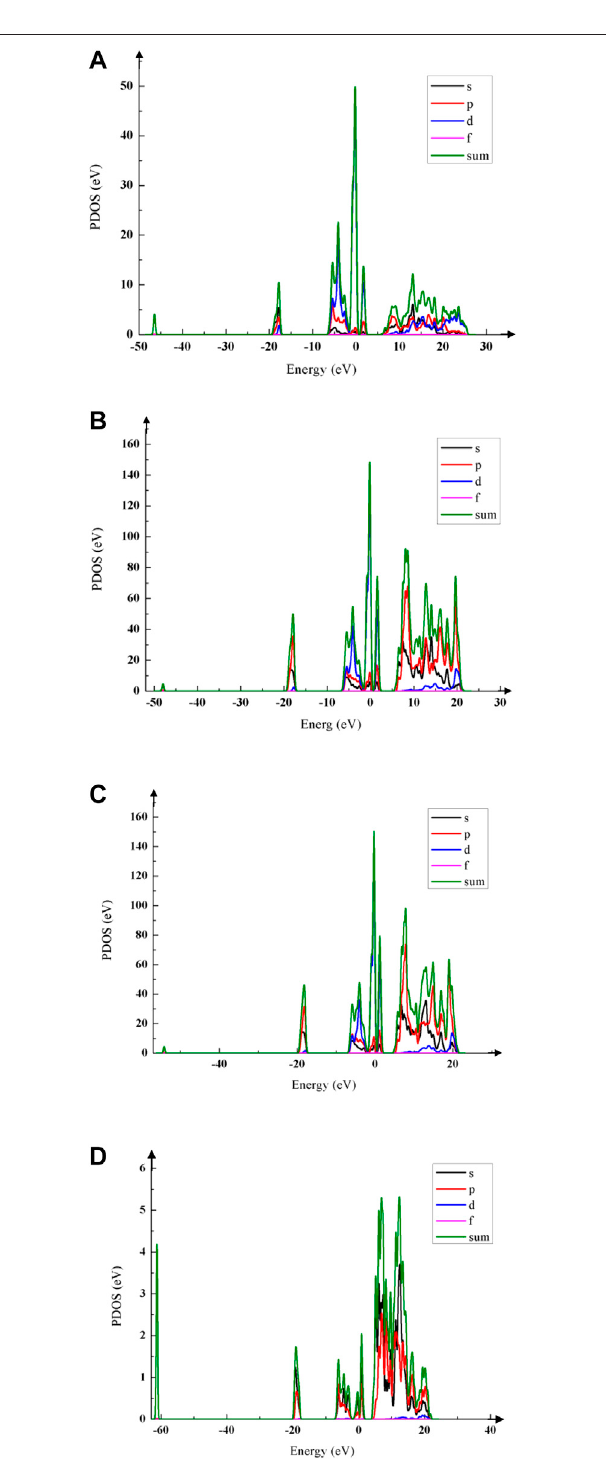
FIGURE 3 | PDOS schemas of Li 1 − x Na x Ni 1/3 Co 1/3 Mn 1/3 O 2 with different Na-doping amount x . (A) When x (cid:2) 0 mol, LiNi 1/3 Co 1/3 Mn 1/3 O 2 is not doped. (B) When x (cid:2) 0.01 mol, PDOS peak of Li 1 − x Na x Ni 1/3 Co 1/3 Mn 1/3 O 2 is higher than that of the pristine. (C) When x (cid:2) 0.05 mol, the PDOS peak rises to about 157 eV, its conductivityis best. (D) When x (cid:2) 0.10 mol, the PDOS peak declines dramatically to 5.5 eV, which is much lower than that of the pristine.